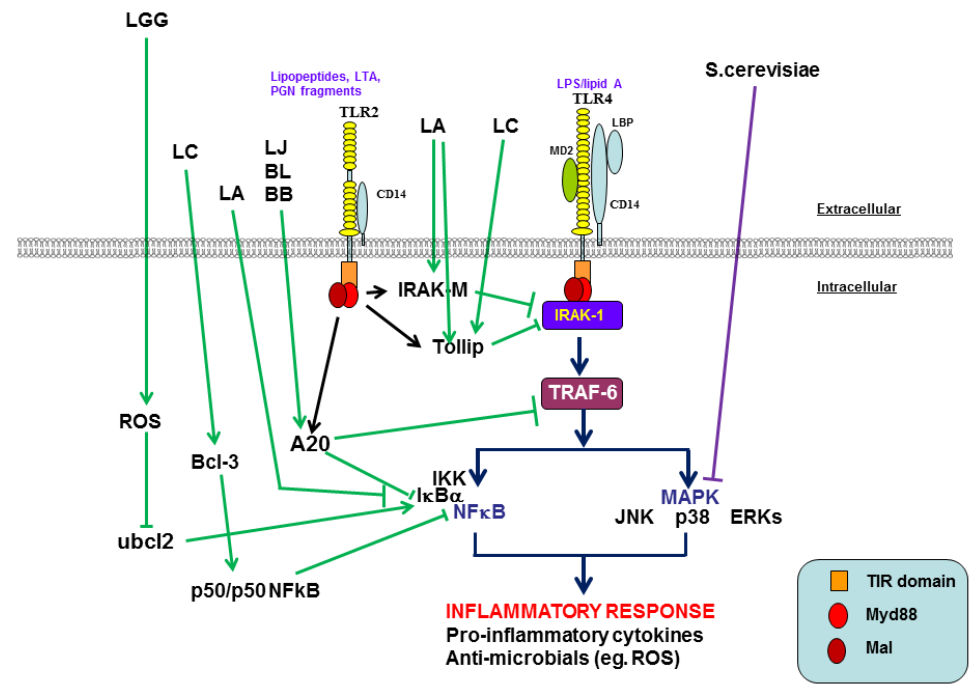
Figure 2. Probiotic modulation of pathogen sensing by TLR-2 and TLR-4 signaling pathways. Probiotic-mediated modulation of TLR-2 and TLR-4 signaling via direct and indirect mechanisms of activation or suppression of distinct signaling molecules/pathways is strain-dependent. Mechanisms of modulation are presented above for a range of strains of bifidobacteria (BL = B. longum strain BB536; BB = B. breve strain M-16V), lactobacilli (LGG = L. rhamnosus strain GG; LC = L. casei strain 0LL2768; LJ = L. jensenii strain TL2937; LA = L. amylovorus strain DSM16698T), and the yeast S. cerevisiae , indicated in the extracellular space above the intracellular post-membrane receptor signaling pathways. TLR signal transduction is initiated by TLR signal adaptor molecules, represented by red ovals, which bind the TIR domains (orange box) on the TLR cytoplasmic region. Signal is passed downstream via activation of IRAK-1 (purple box) and TRAF-6 (maroon box), resulting in the activation of NFkB and MAPK pathways. Arrowed lines are activatory, blunted lines are suppressive/inhibitory. Probiotic bacteria regulate inflammatory responses via induction of a range of endogenous negative regulators of TLR signaling (IRAK-M, Tollip, A20, Ubcl2, Bcl-3 and p50/p50 NFkB homodimer). TLR2 ligation may induce a suppressive effect on TLR4-mediated inflammatory responses via expression/activation of IRAK-M and Tollip. S. cerevisiae can exert a suppressive effect on inflammatory responses via inhibition of MAPK pathways (p38, JNK and ERKs). At this time, studies represented in this figure use a range of cells/cell lines; selective manipulation of signal checkpoint molecules and pathways is likely to represent a cell and cell subset-specific